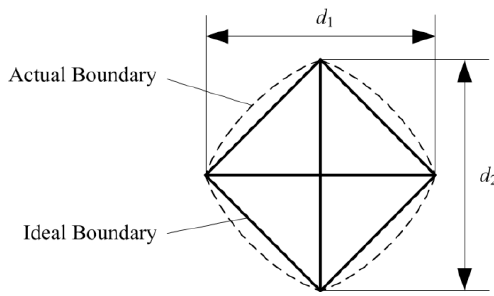
Figure 2. Schematic diagram of residual impression.